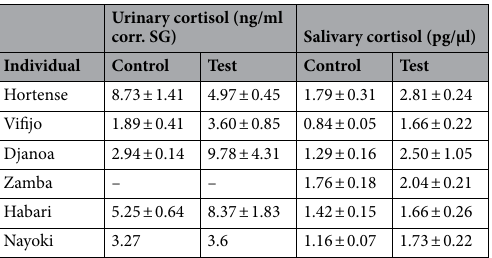
Table 4. Mean (± SEM) urinary and salivary cortisol concentrations per individual.